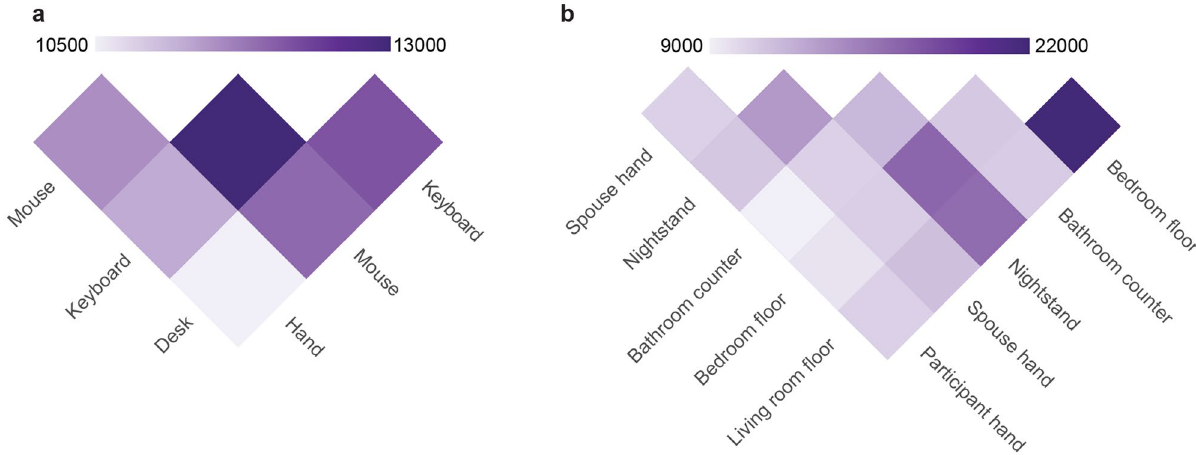
Figure 4. Shared OTUs by sample type: ( a ) heat map representation of the summed shared OTUs between each sample type for the office environment; ( b ) heat map representation of the summed shared OTUs between each sample type for the home